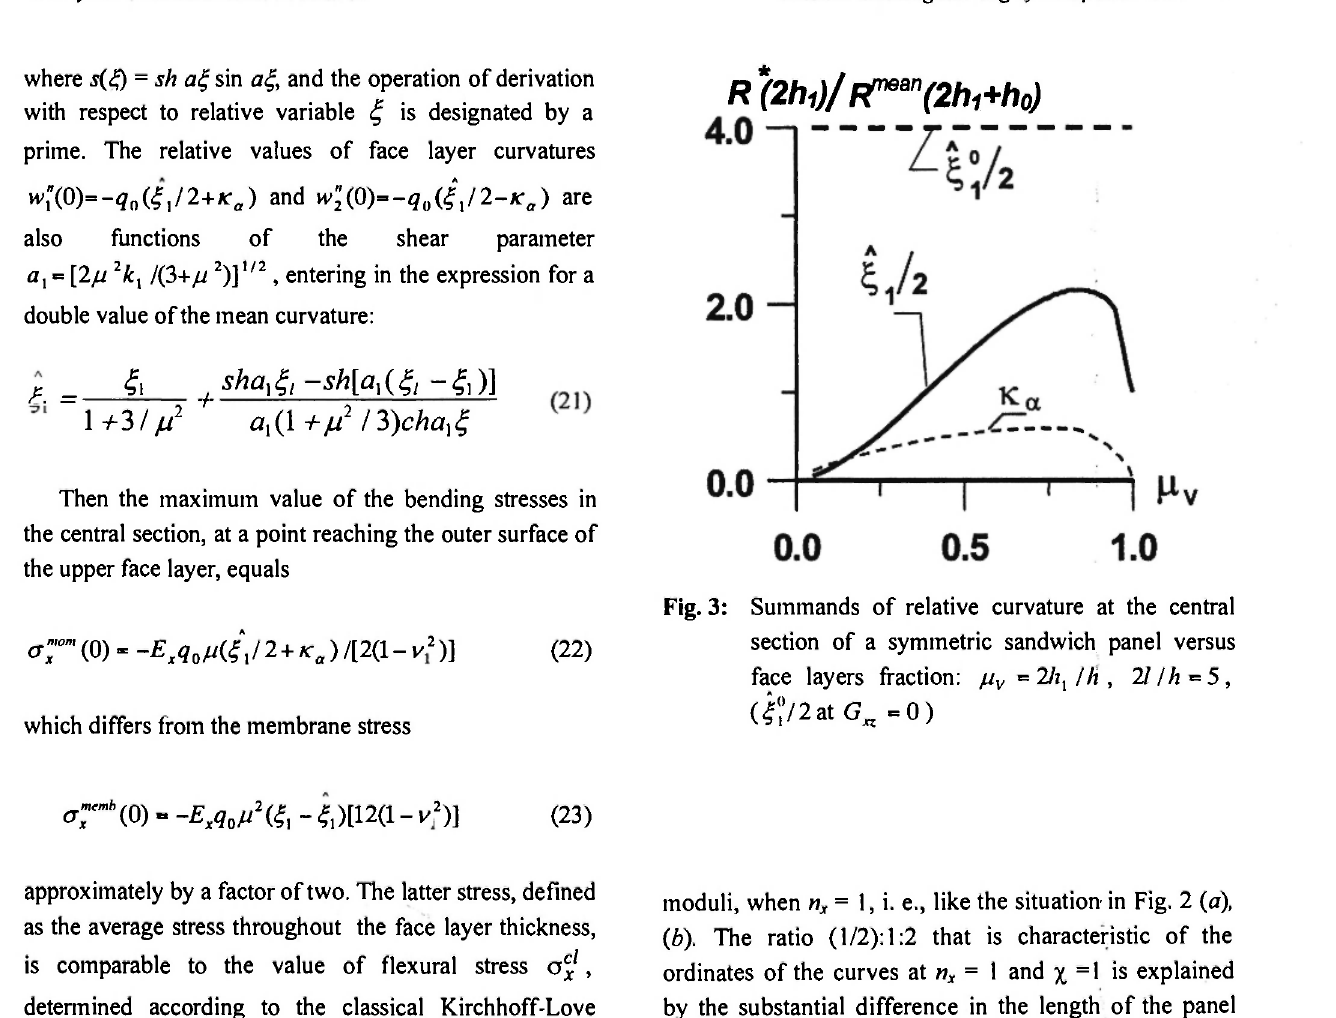
Fig. 3: Summands of relative curvature at the central section of a symmetric sandwich panel versus face layers fraction: μ ν = 2Λ, !h , 2// h =